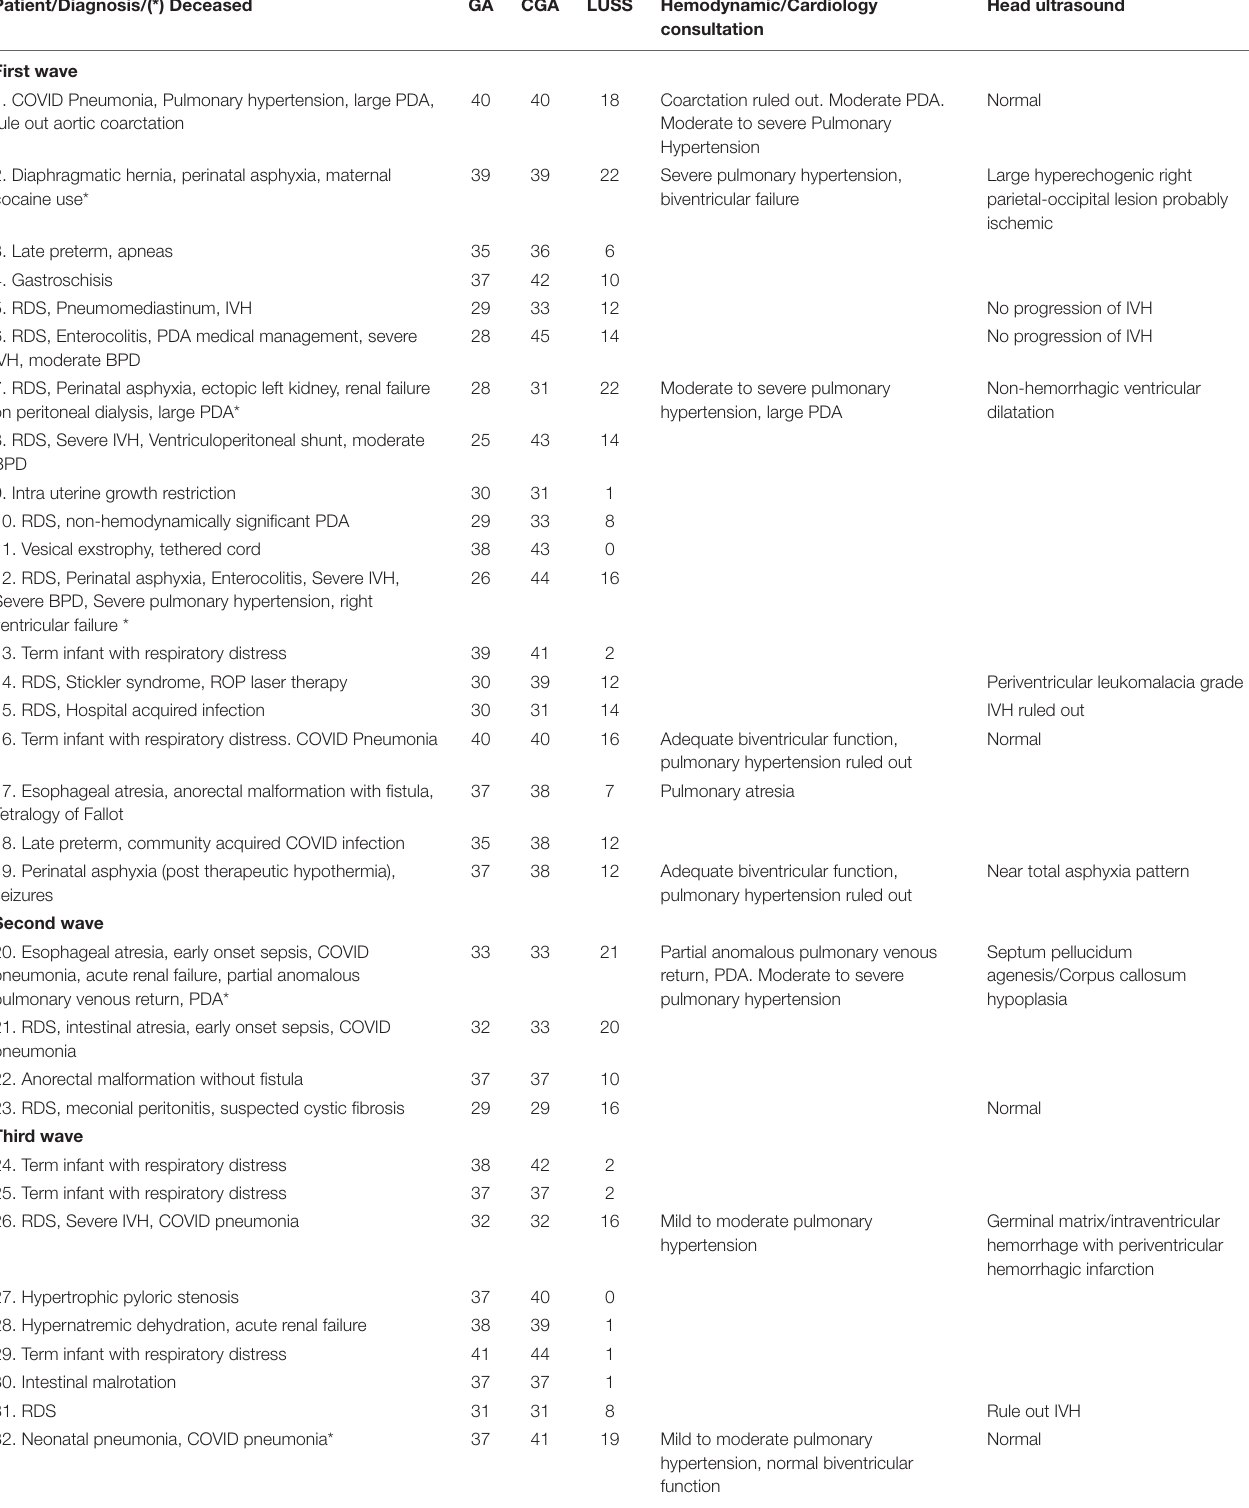
TABLE 2 | Ultrasonographic assessment during the acute phase of the SARS-CoV-2 infection. Patient/Diagnosis/(*) Deceased GA CGA LUSS Hemodynamic/Cardiology